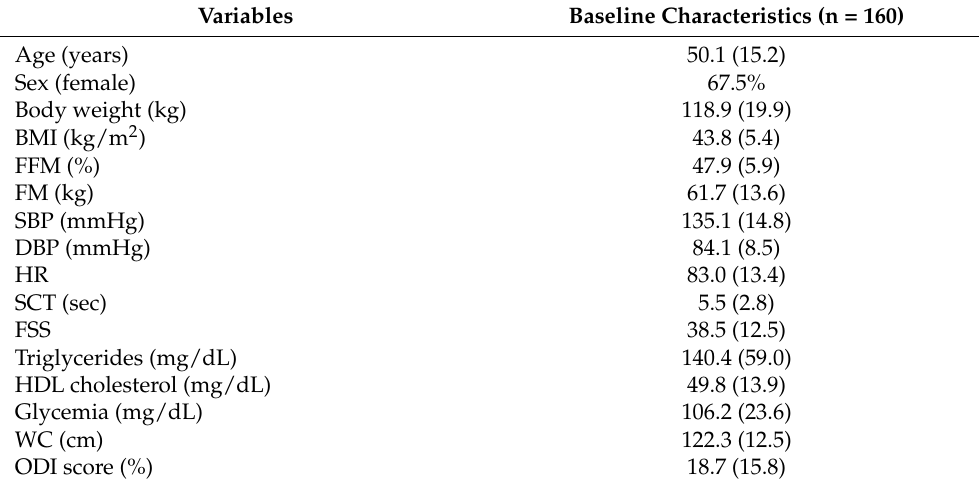
Table 1. Participants’ characteristics at baseline (mean ± SD).